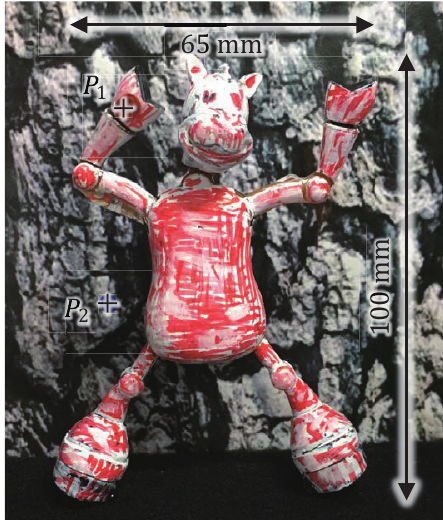
Figure 16. Dancing horse doll to be observed.